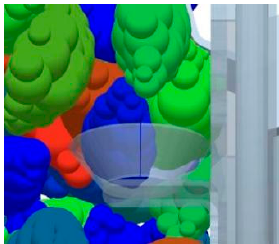
Figure 13. Replay status.